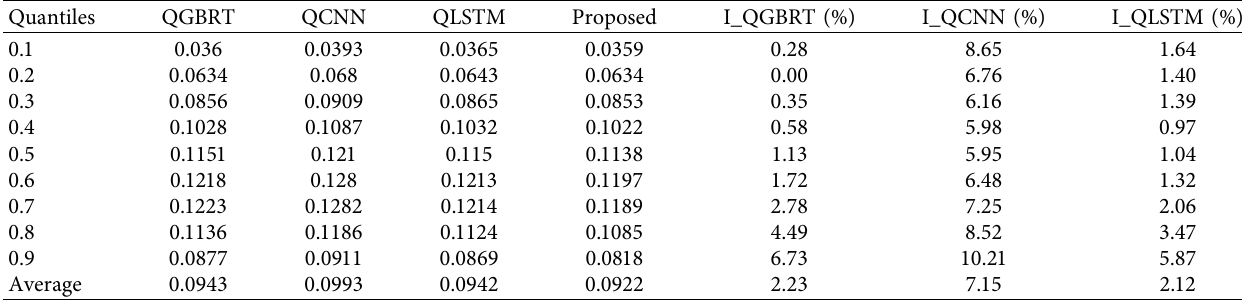
Figure 8: Heat map with AQS metrics for evaluation of four models. QGBRT, QCNN, QLSTM, and our proposed model in X -axis correspond to AQS for different models, while I_QGBRT, I_QCNN, and I_QLSTM represent the AQS improvement ratio compared with the proposed model. Y -axis denotes different residences. Results in each residence are described in the same row, where darker green shades imply a better performance. Table 2: Average quantile score from 0.1 to